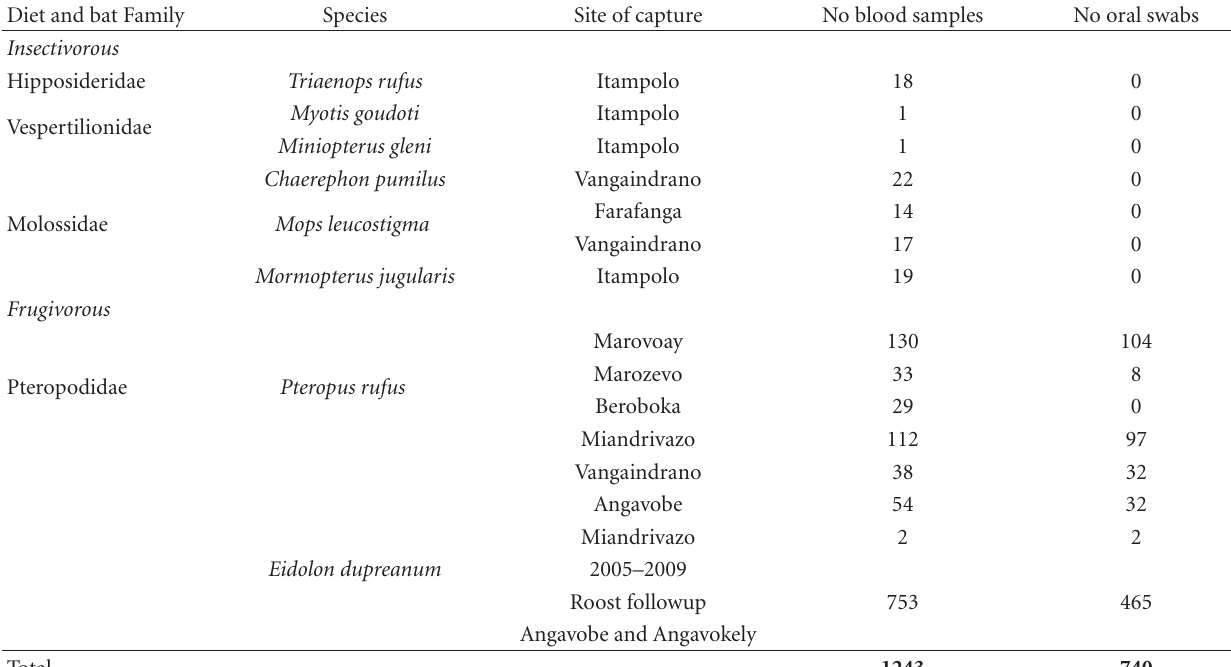
Table 3: Bats samples tested for lyssavirus, according to the species and the site of capture, Madagascar 2005–2009. Diet and bat